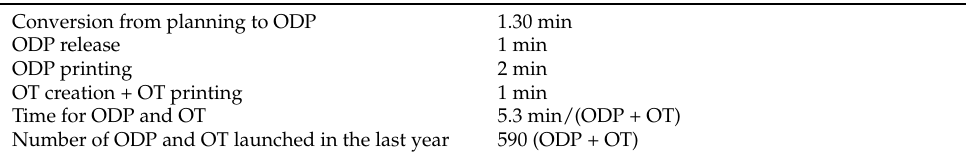
Table 2. Main activities connected to the launch of a production order from the perspective of the planning office.